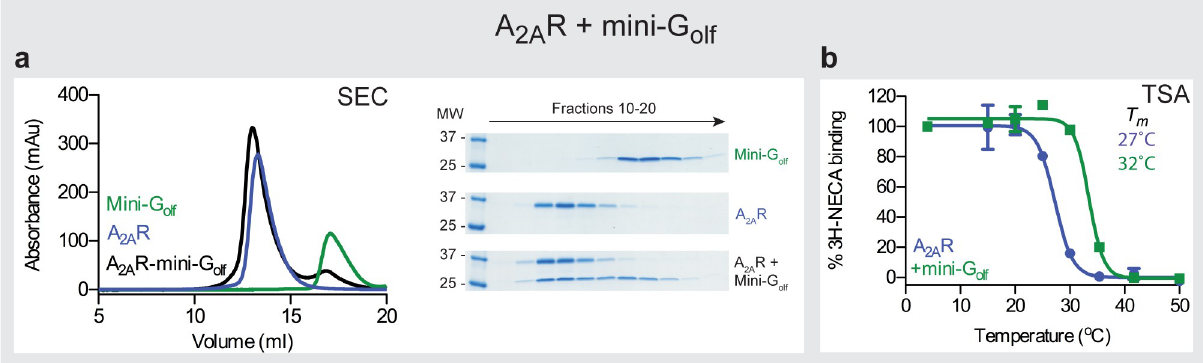
Fig 4. The A 2A R − mini-G olf complex. ( a ) Analytical SEC of mini-G olf bound to purifiedA 2A R (retentionvolumes are given in parentheses): black,